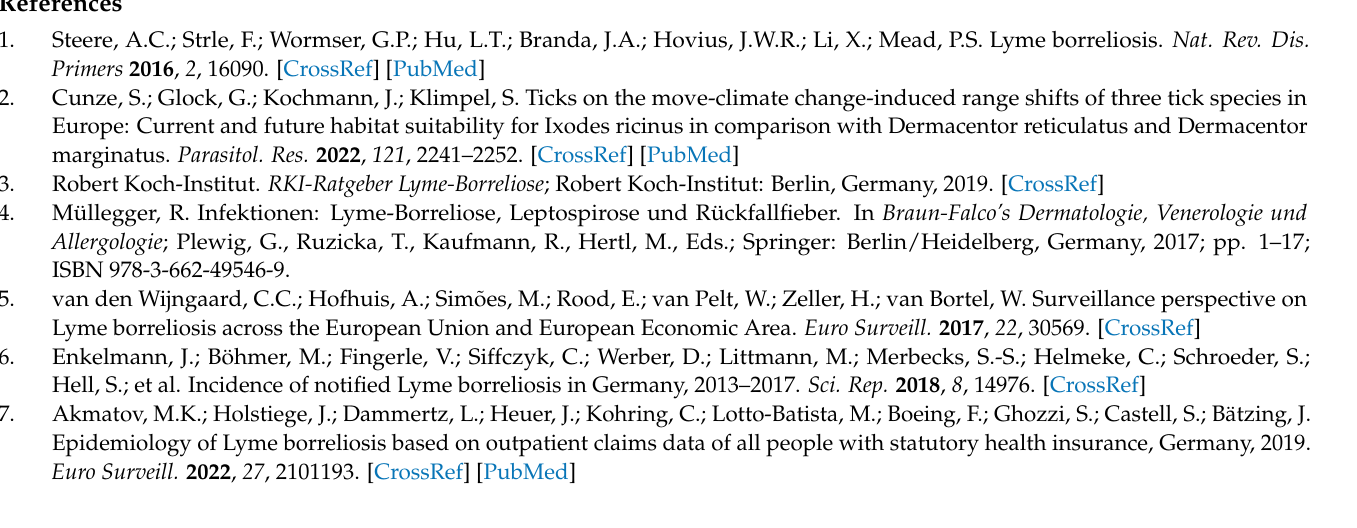
Table S3: Estimated mean force of infection (FOI) for IgG seropositivity against B. burgdorferi